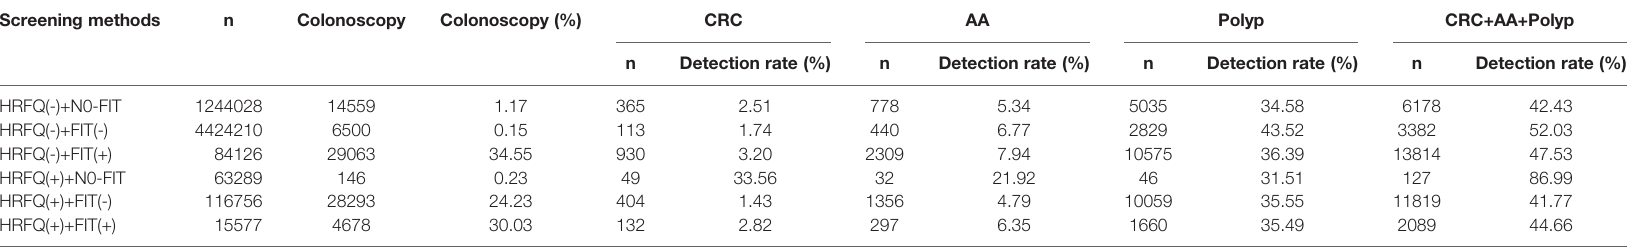
TABLE 9-3 | Distribution of colonoscopy results among different screening methods in Tianjin CRC screening program (2012-2020), (n, %). Screening